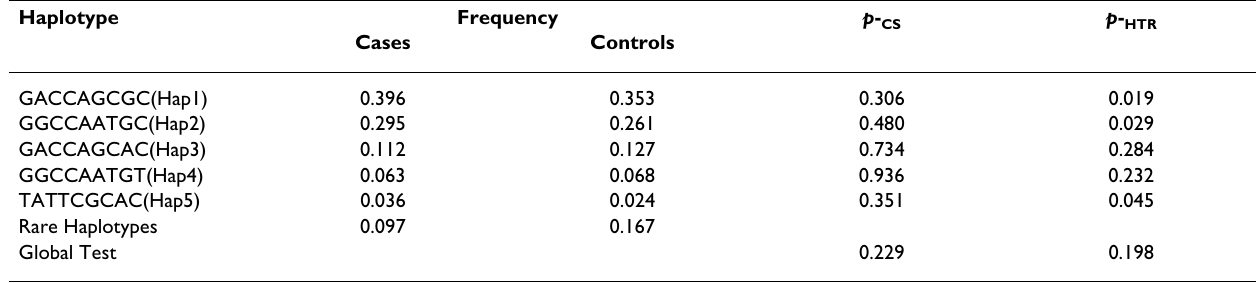
Table 7: ELN haplotype frequencies inferred by PHASE and HTR and the corresponding p-values showing the levels of difference between cases and controls. Haplotype